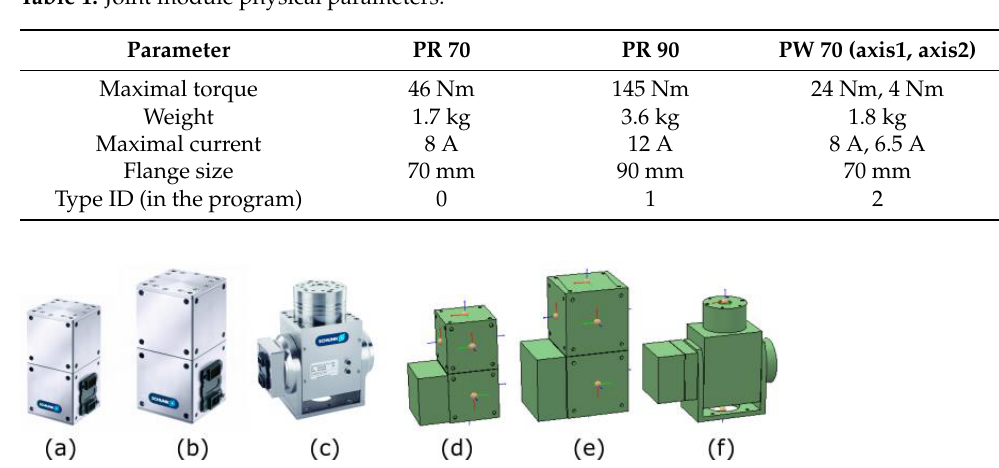
Figure 1. Example of a manipulator with links, joints, and an end-effector.